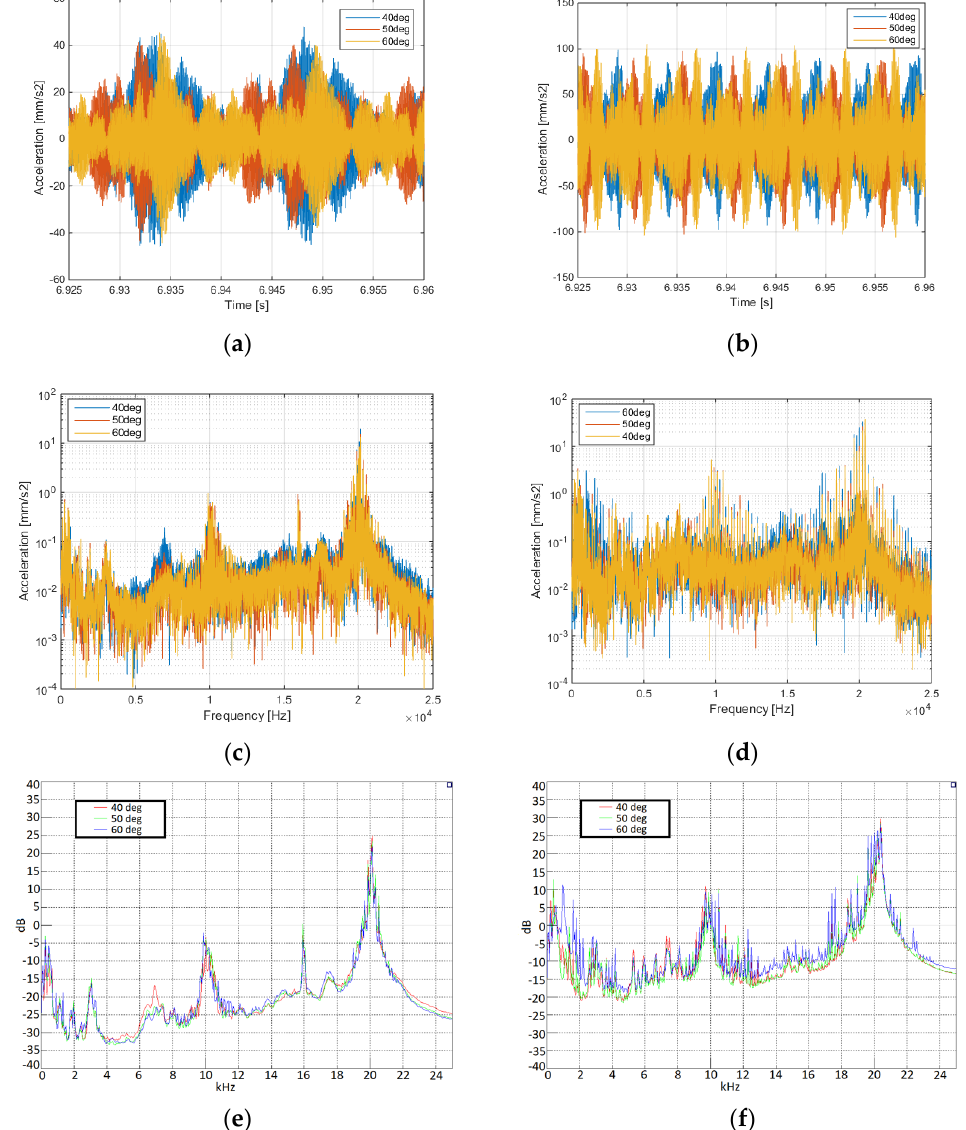
Figure 21. Vibration of the machine at various current angles: ( a ) 1000 rpm—time waveform; ( b ) 3000 rpm—time waveform; ( c ) 1000 rpm—FFT; ( d ) 3000 rpm—FFT; ( e ) 1000 rpm—power spec- trum; ( f ) 3000 rpm—power